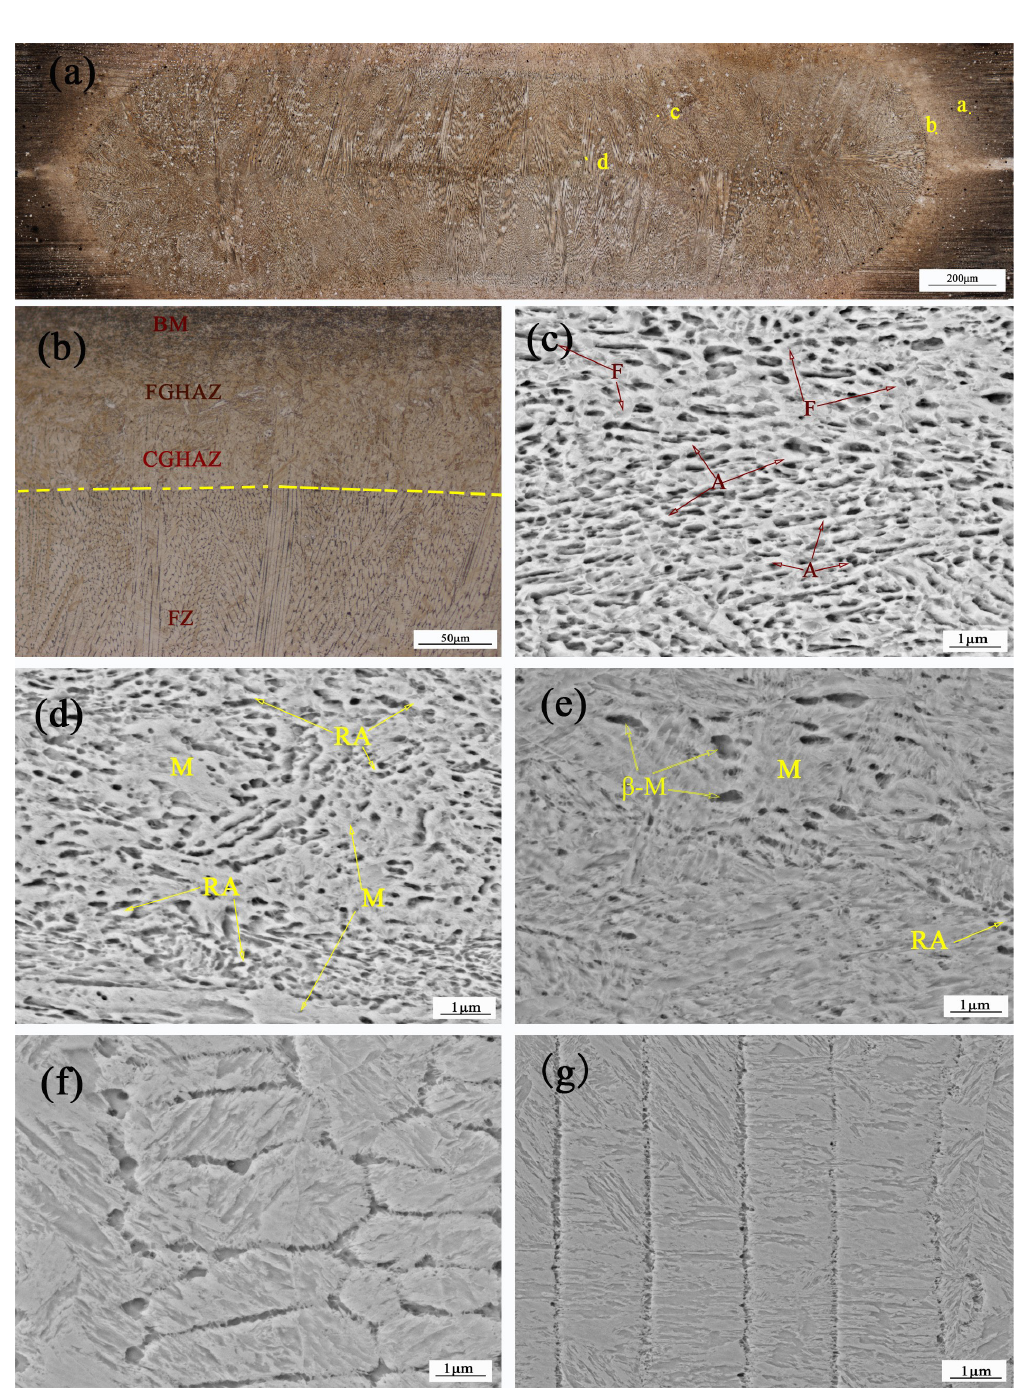
Figure 2. Macromorphology and microstructure of nugget in Fe-0.13C-7Mn TRIP steel: (a) macromorphology of nugget; (b) tissue evolution from base metal to fusion zone. Structures of the (c) heat affected zone, (d) fine grain heat affected zone, (e) coarse grain heat affected zone, and ((f) and (g)) fusion zone